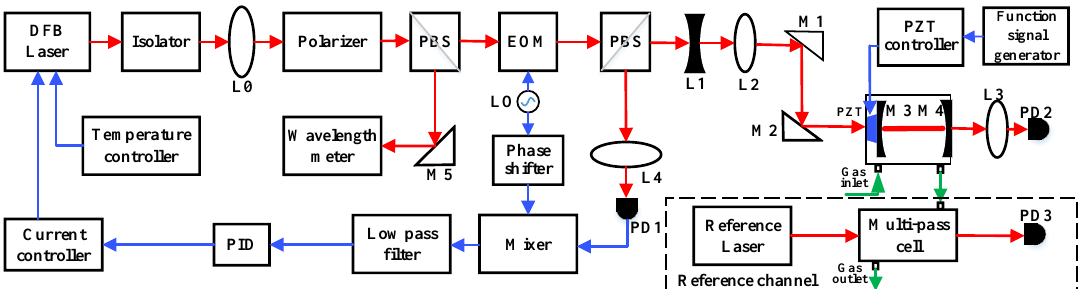
Figure 1. Schematic of the near-infrared repetitively mode-locked cavity-enhanced sensor system. The red lines represent the diode laser beam, and the blue lines represent electrical signals. A reference LDAS (Laser Direct Absorption Spectroscopy)-based sensor system shown by a dashed line including a reference laser, multi-pass gas cell and a photodetector (PD3), were used to measure the H 2 O concentration.